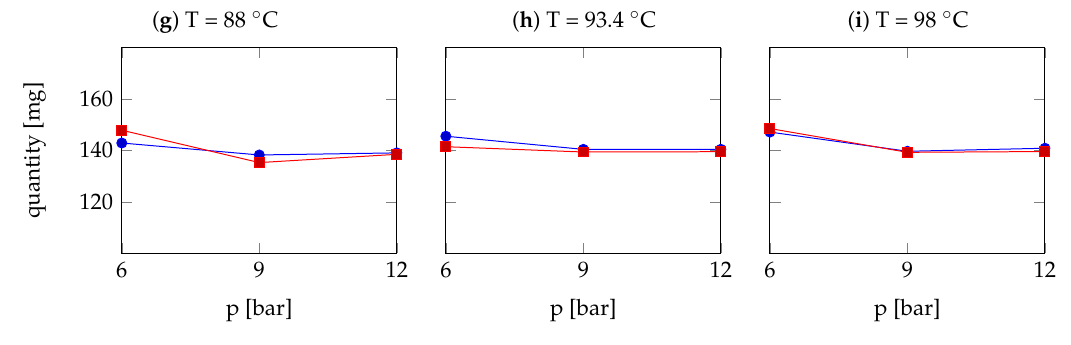
Figure 5. Comparison between the trigonelline extracted through numerical simulations (blue profile with circles) and laboratory measurements (red profile with squares), with different inlet water temperatures and pressures and different grain size of Arabica coffee powder. Figures ( a – c ) show the results of optimal granulometry, Figures ( d – f ) of coarse granulometry and Figures ( g – i ) of fine granulometry.